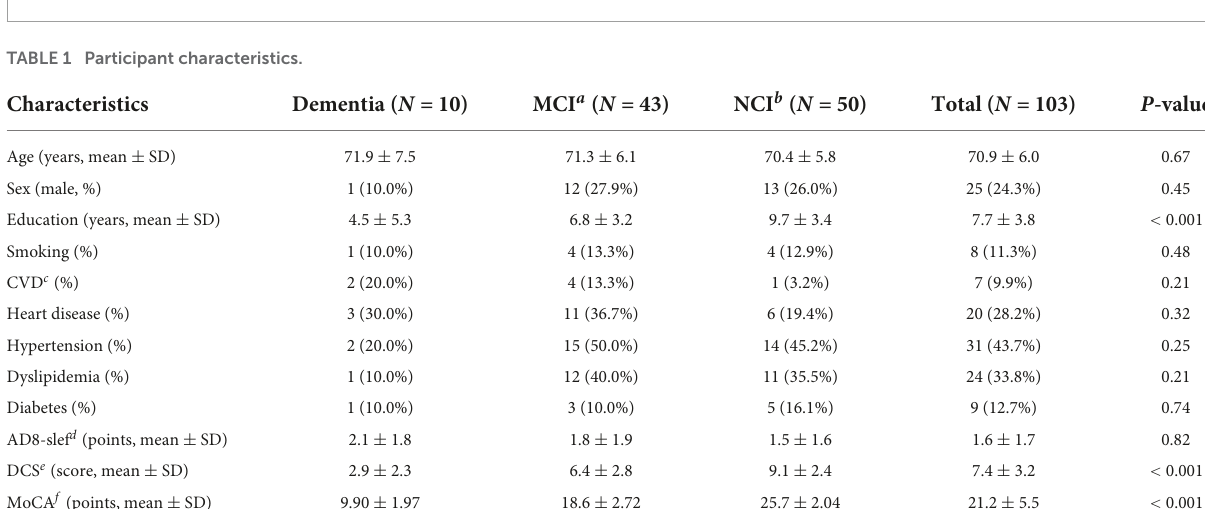
FIGURE2 Flow diagram of participants.